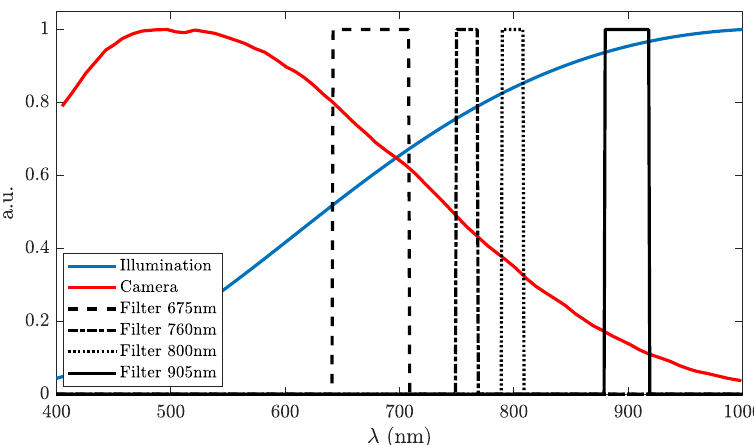
Figure 6. The experimental setup comprises two armatures with incandescent light bulbs (blue) and four identical monochrome cameras (red) equipped with different optical filters (black) to obtain spectral selectivity. This information is used to calculate the values for the pulse signature vector (Equation (4)).